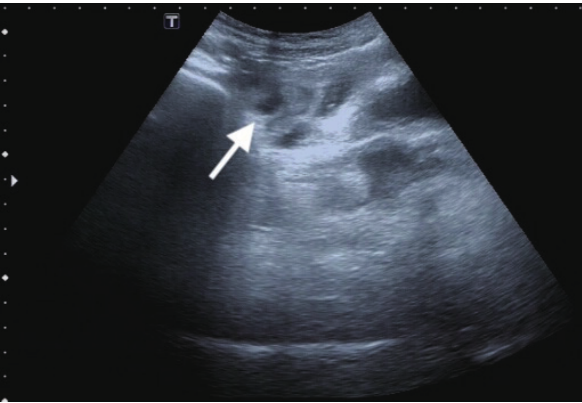
Figure 4 Three days later, dilated intestines returned to normal (white